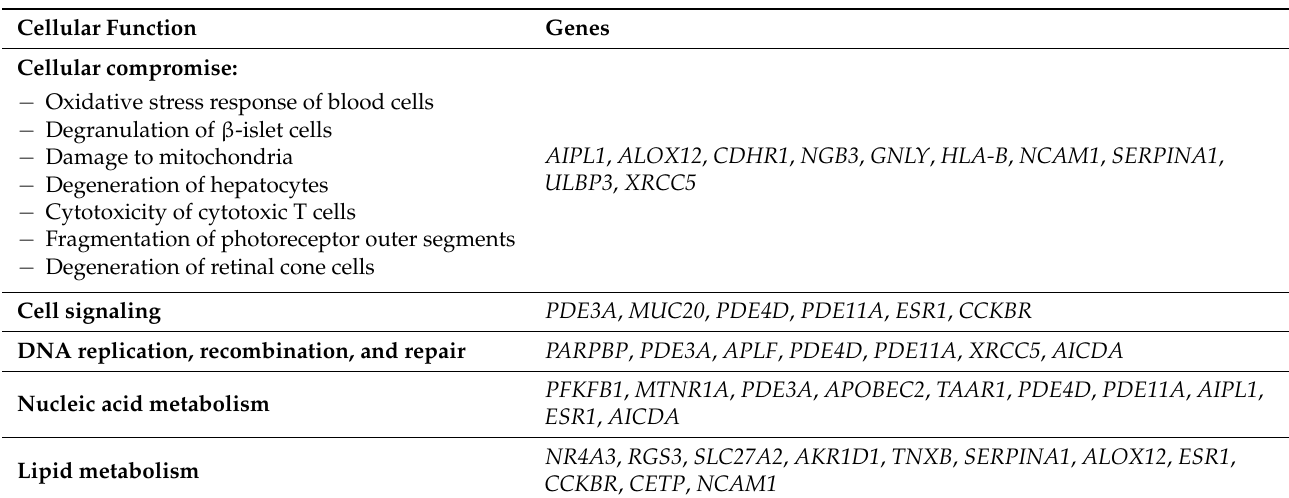
Table 4. Main cellular functions that are most influenced by adaptogens; adapted from Reference